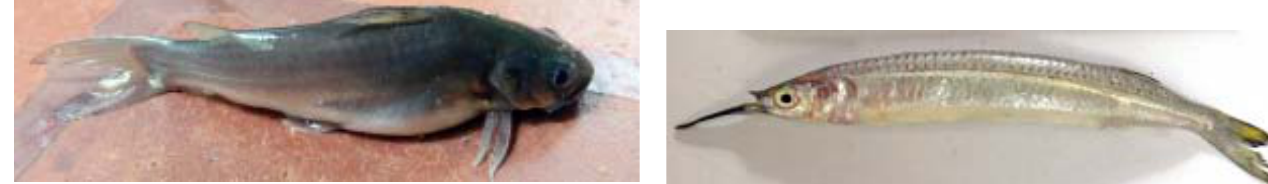
Image 13. Long-whiskered Catfish Mystus gulio